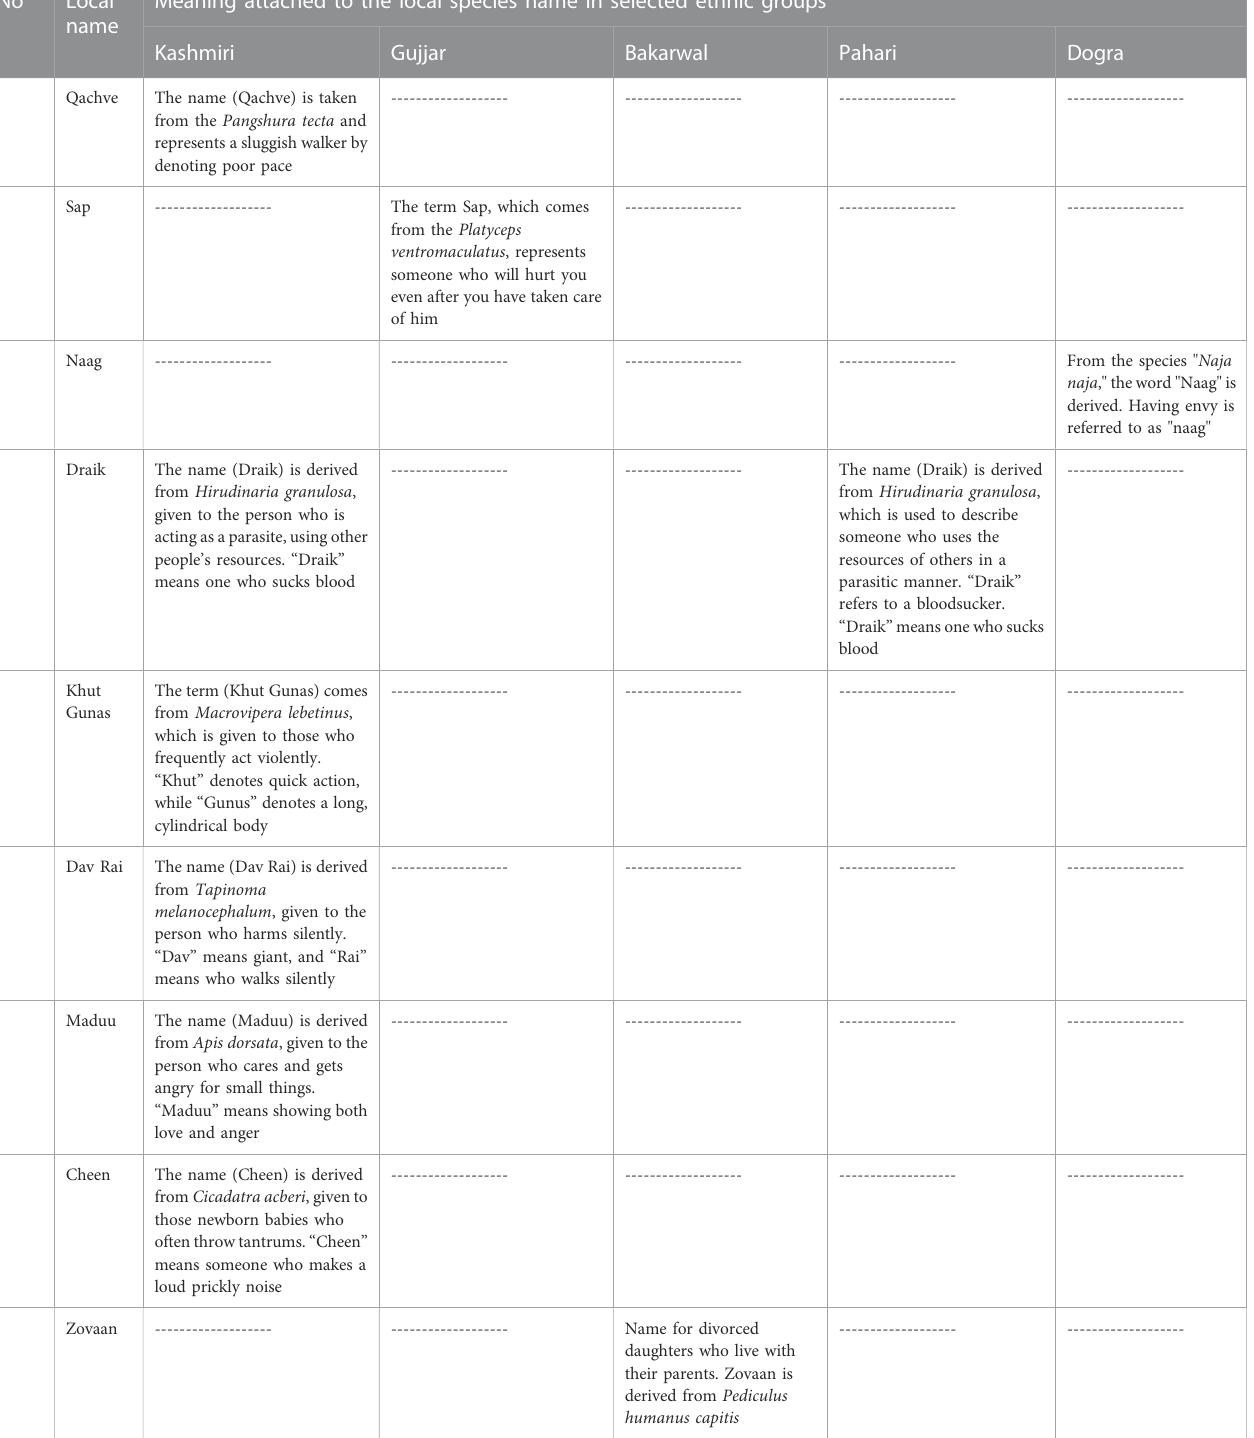
TABLE 3 Anthroponyms and societal nomenclature in Jammu and Kashmir, India. S.No